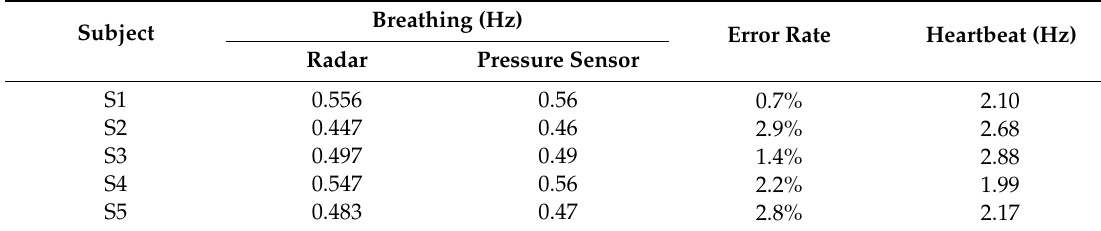
Table 2. Vital sign measurement results of five cats.